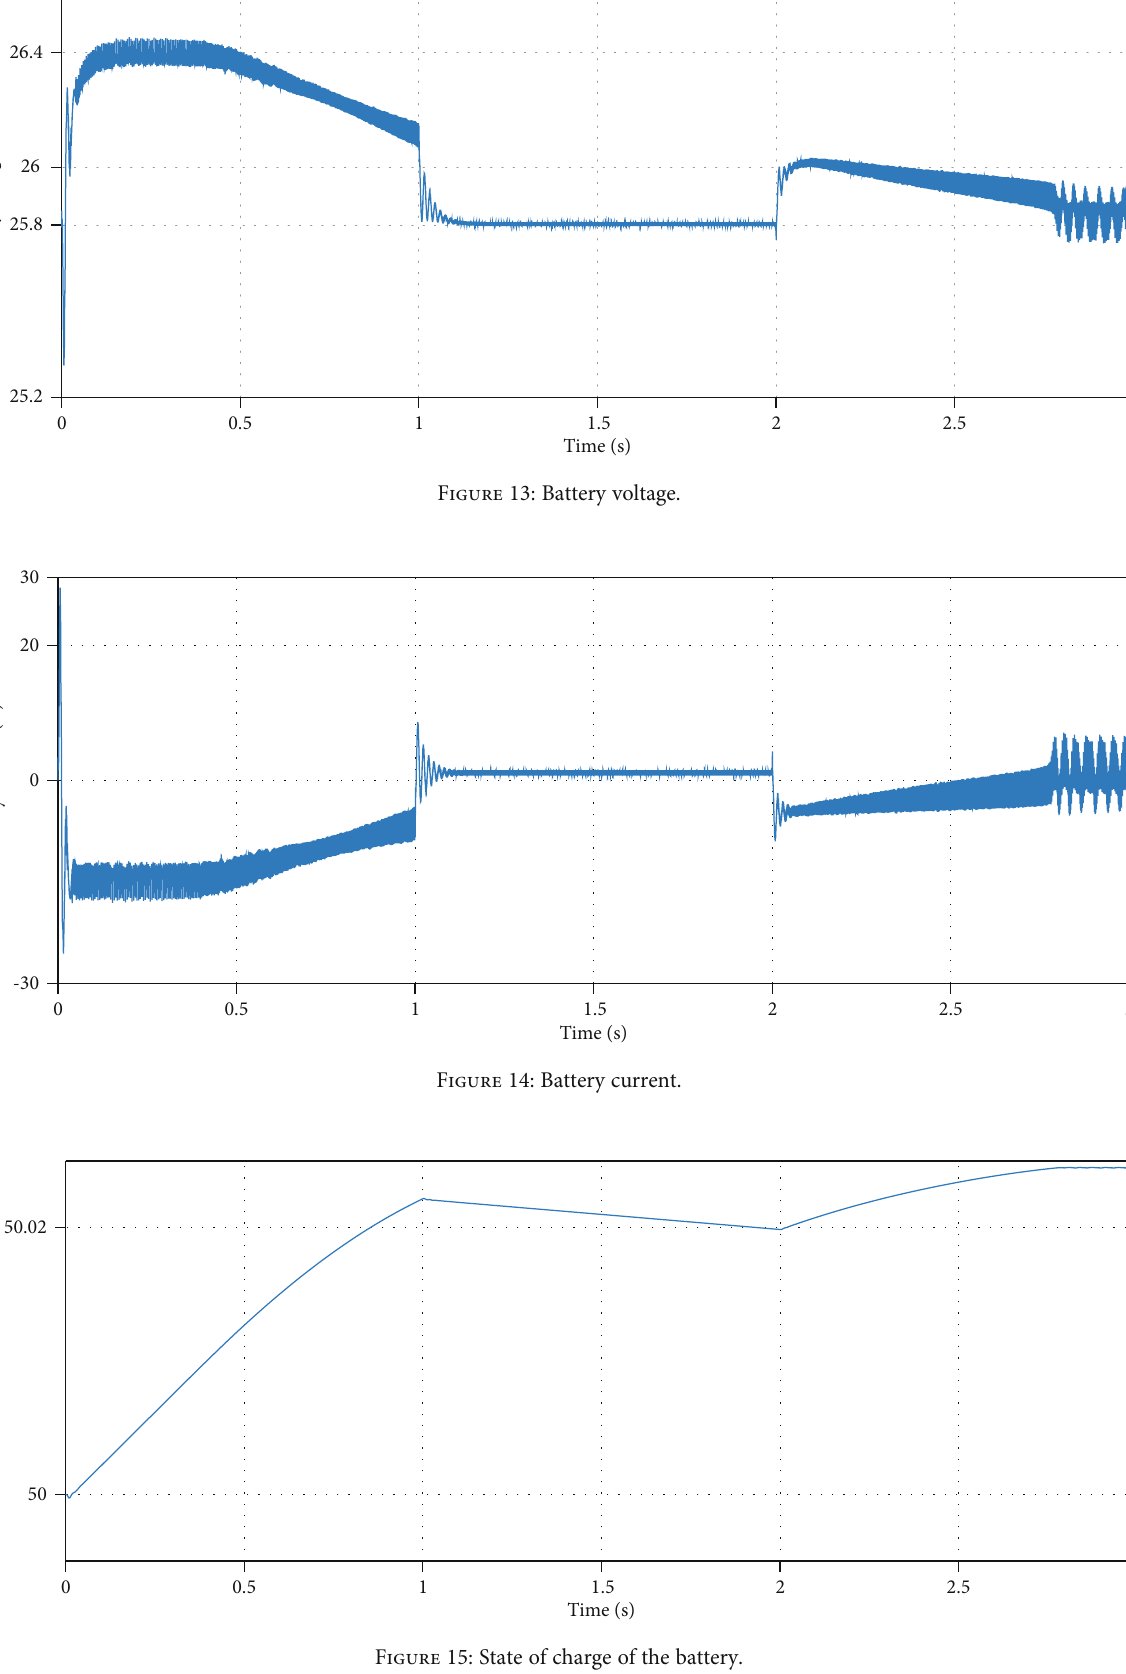
Figure 15: State of charge of the battery.